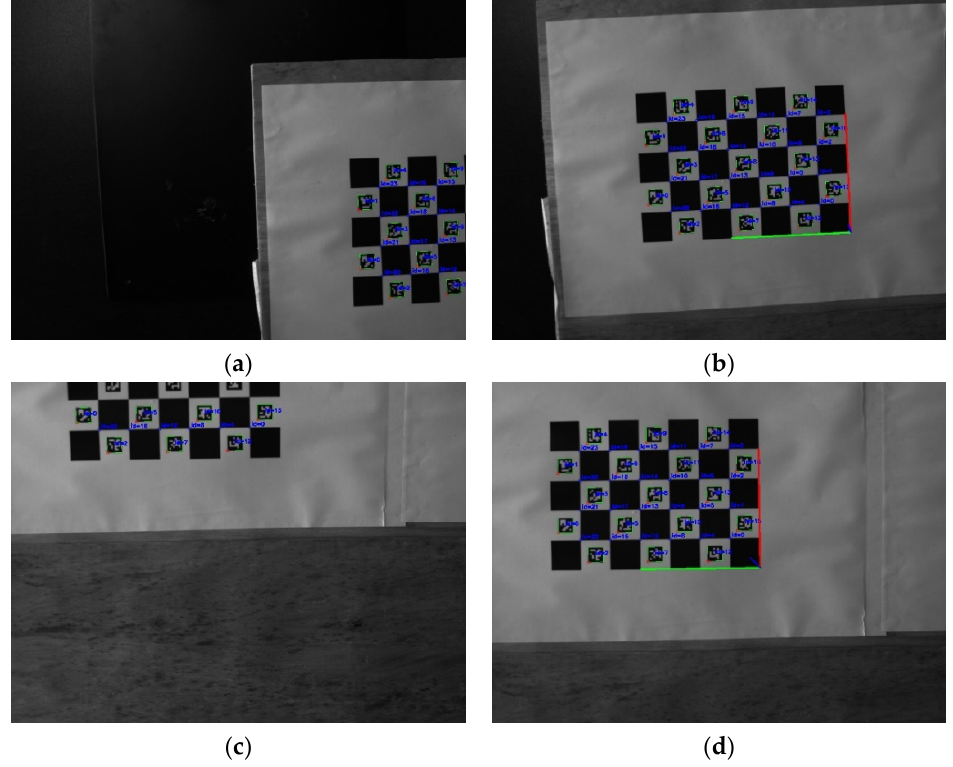
Figure 12. Online hand–eye calibration experiment, based on ChArUco board: ( a , c ) Image captured by camera before robot adjustment; ( b , d ) Image captured by camera after robot adjustment.